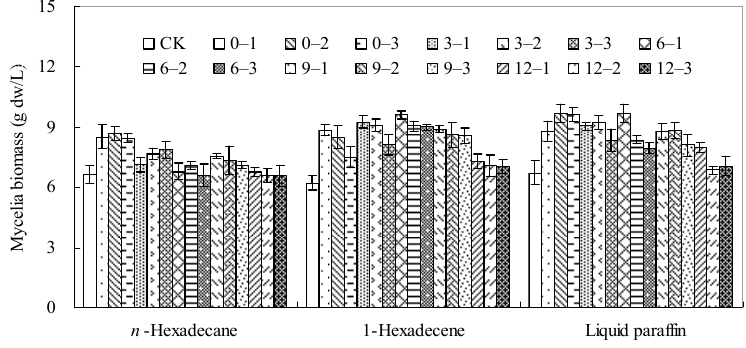
Figure 2. Effects of n -hexadecane, 1-hexadecene and liquid paraffin on mycelia growth in liquid culture of Berkleasmium sp. Dzf12. The organic solvents were applied at 5%, 10% and 15% on days 0, 3, 6, 9 and 12 of culture, respectively. The period of culture lasted for 15 days. “CK” means the control without any organic solvents. 0-1, 0-2 and 0-3 mean that the organic solvent was applied on day 0 at 5%, 10% and 15%, respectively. 3-1, 3-2 and 3-3 mean that the organic solvent was applied on day 3 at 5%, 10% and 15%, respectively. 6-1, 6-2 and 6-3 mean that the organic solvent was applied on day 6 at 5%, 10% and 15%, respectively. 9-1, 9-2 and 9-3 mean that the organic solvent was applied on day 9 at 5%, 10% and 15%, respectively. 12-1, 12-2 and 12-3 mean that the organic solvent was applied on day 12 at 5%, 10% and 15%, respectively. The error bars represent standard deviations from three independent samples. Table 1. Physicochemical properties of the employed organic solvents.